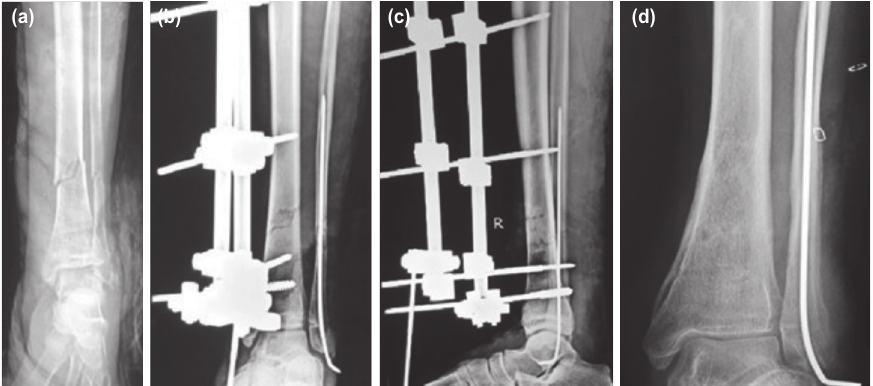
(a,b,c,d) Grade 3B open tibia fracture united at 23 weeks with primary definitive external fixation and immediate wound cover Fig. 7: with RSA flap.